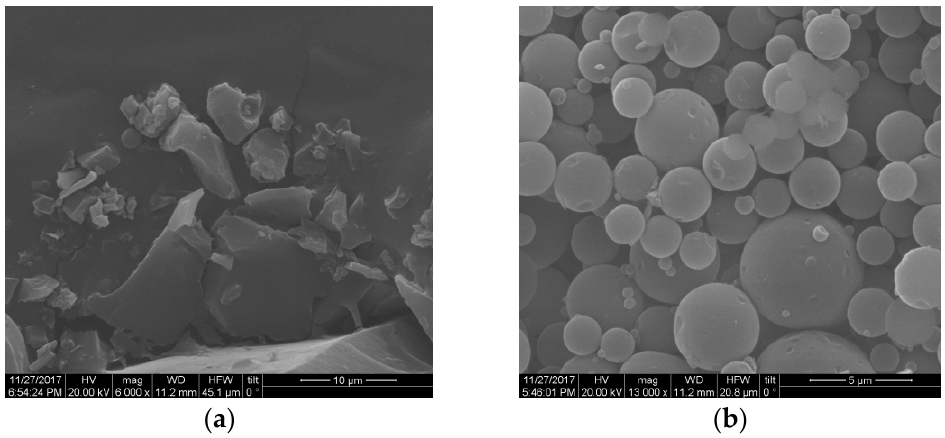
Figure 1. Morphology of lignin after HOS-SE pretreatment, ( a ) with sulfuric acid catalyst; ( b ) without sulfuric acid catalyst. Pretreatment took place at 200 °C for 15 min with 60% v/v ethanol content.